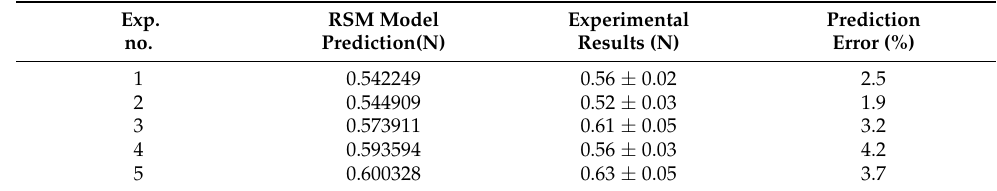
Table 7. Validation test results, including the mean, the standard deviation, and the prediction error of the experimental